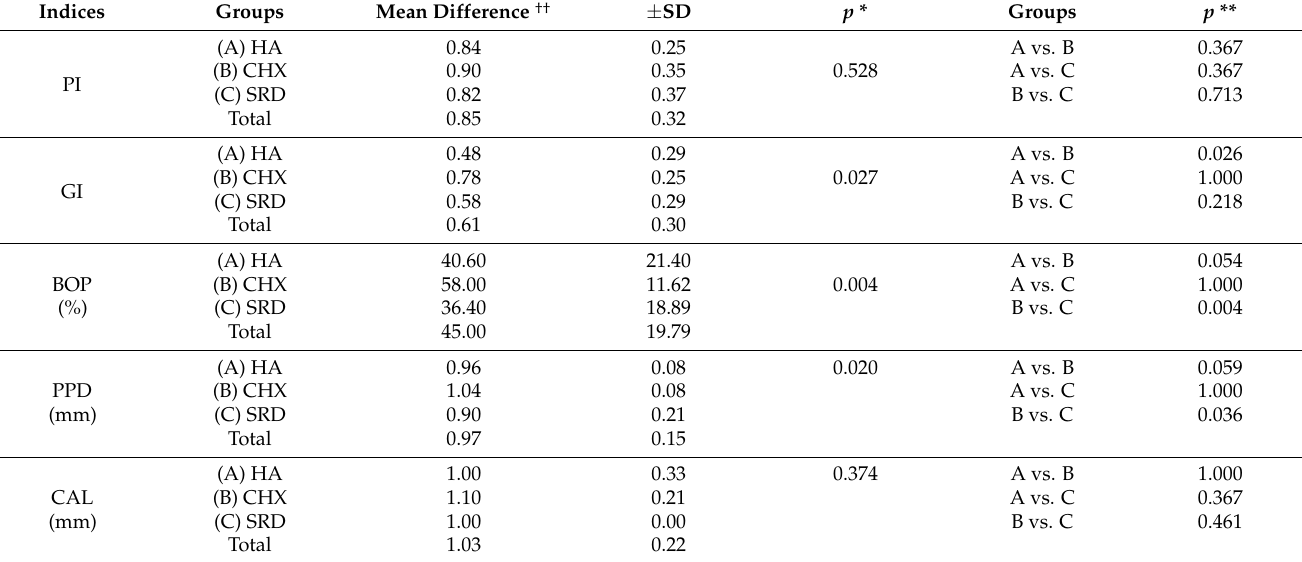
Table 2. Mean differences (before and after therapy) in clinical parameters for the three studied